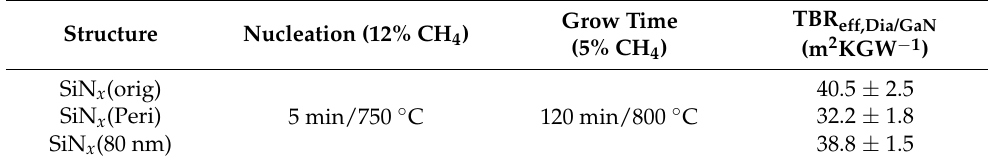
Table 3. Fit model results of TBR eff,Dia/GaN with different SiN x